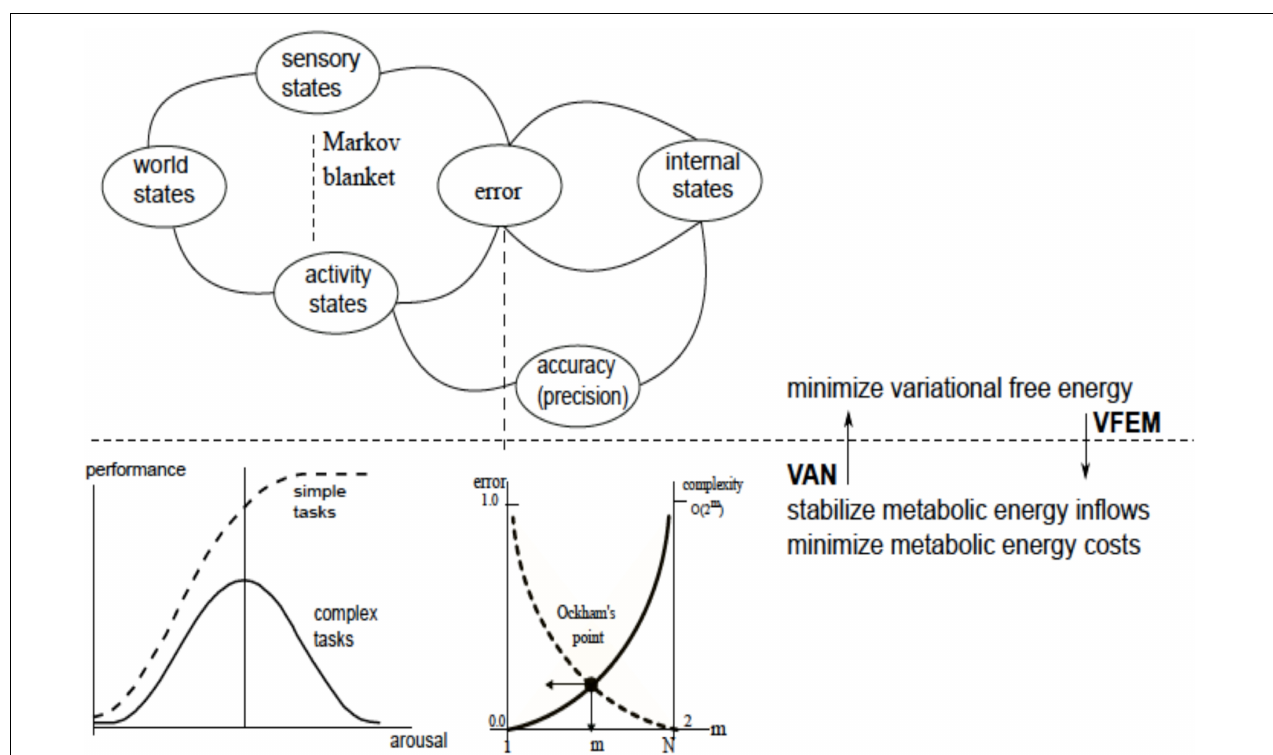
FIGURE 12 | VAN theory instantiates VFEM framework, by accounting for error optimization mechanisms underlying human understanding. The figure above the horizontal dotted line depicts a VFEM construct where adaptive interaction between world states and the brain (internal states) is conducted via motor-sensory loop and pivots on the mechanisms of error minimization and precision adjustment (adopted from Solms and Friston, 2018). Figure below the horizontal dotted line summarizes the VAN approach deriving error optimization from capabilities inherent in self-directed packet manipulation (see Figure 9 ). Vertical dotted lines suggest mapping between the VFEM and VAN constructs. The sensory and activity states constitute Markov Blanket that shields internal states from the world states and, at the same, mediates interaction between